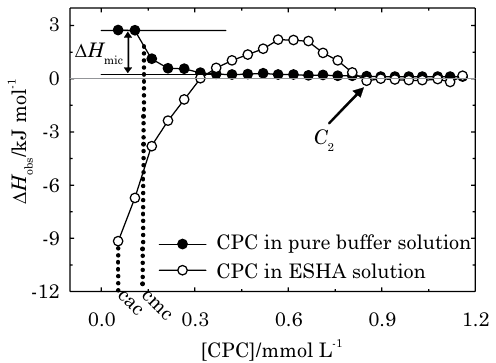
figure 1. calorimetric titration curves (observed enthalpy changes – ∆ H obs ) from the addition of hexadecylpyridinium chloride monohydrate (cPc) surfactant solution (10.0 mmol L -1 ) to the elliott soil humic acid (eSha) solution (0.1 mg mL -1 ) and its dilution in carbonate buffer at 25 o c and 0.05 mol L -1 ionic strength (iS). The acronyms cac , cmc , and C 2 stand for critical aggregation concentration, critical micelle concentration, and saturation concentration,